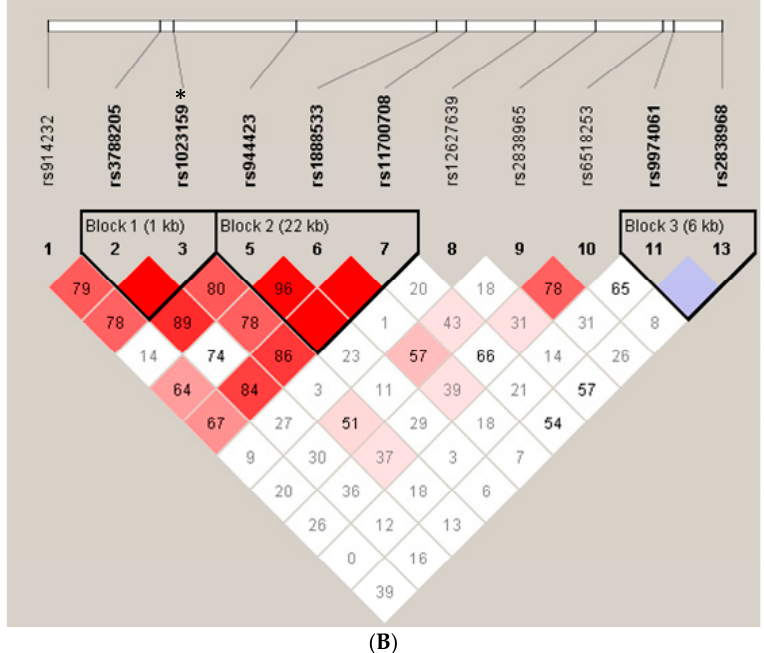
Figure 1. The genomic structure of SLC19A1 ( A ). Bars, exons. Arrows, positions of single nucleotide polymorphisms (SNPs). Linkage disequilibrium plot of SNPs in the samples studied ( B ). Numbers in squares indicate D ′ values. Reference Number (rs) with asterisk indicates the SNP with p < 0.05. The blocks are defined following the four-gamete rule [22]. Explanation of color scheme: If D ′ < 1 and LOD (log of the likelihood odds ratio) <2, the cell color is white; if D ′ = 1 and LOD < 2, the cell color is blue; if D ′ < 1 and LOD ≥ 2, the cell color is shades of pink/red; if D ′ = 1 and LOD ≥ 2, the cell color is bright red. Table 1. Genotype and allele frequencies of rs1023159 at Kanazawa University Hospital for autism spectrum disorder (ASD).